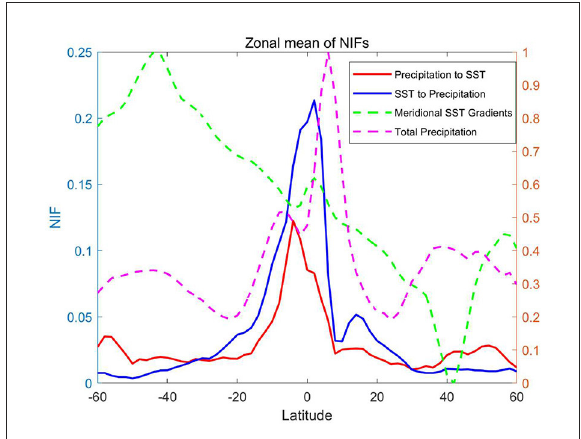
FIGURE6 Ratio for the local and maximum remote NIFs (A) from global SST to local precipitation and (B) from global precipitation to local SST. The relative importance of local impact becomes increasingly large as the value approaches